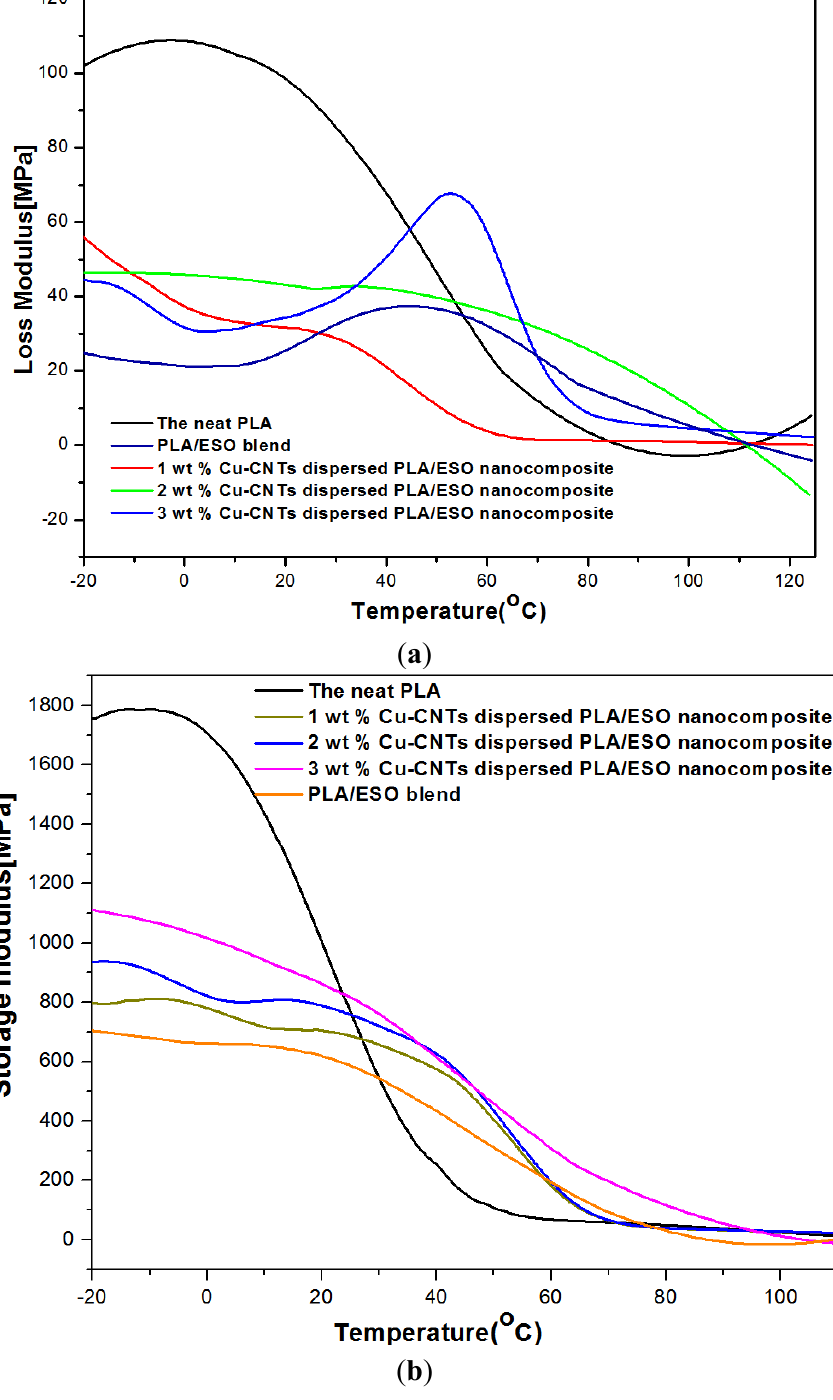
Figure 2. ( a ) Dynamic mechanical analysis (DMA) loss modulus of the as-prepared samples; ( b ) DMA storage modulus of the as-prepared samples.